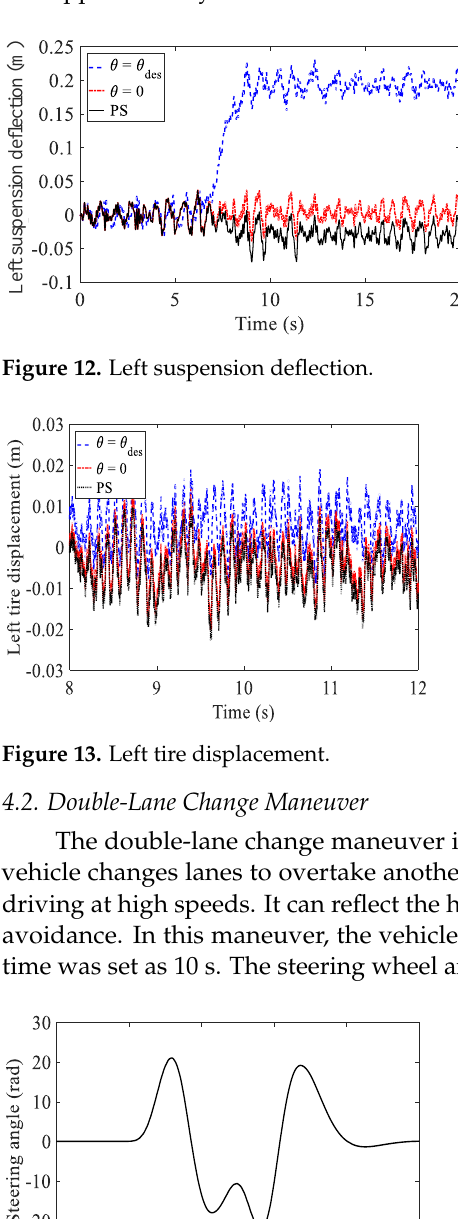
Figure 11. Side-slip angle of the vehicle center of gravity.